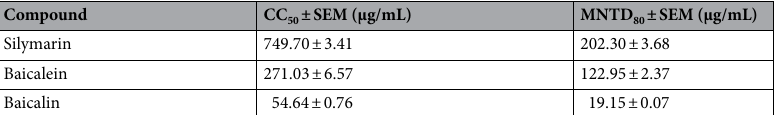
Table 1. Concentrations up to 200 µg/mL for silymarin (Fig. 1a), 100 µg/mL for baicalein (Fig. 1b), and 20 µg/ mL for baicalin (Fig. 1c) showed no significant cytotoxic effects in Vero cells after 48 h of incubation. The half-maximum cytotoxic concentration (CC 50 ) of silymarin, baicalein, and baicalin was 749.70 ± 3.41 µg/mL, 271.03 ± 6.57 µg/mL, and 54.64 ± 0.76 µg/mL, respectively. The maximum-non-toxic-dose (MNTD 80 ) of silyma- rin, baicalein and baicalin was 202.30 ± 3.68 µg/mL, 122.95 ± 2.37 µg/mL, and 19.15 ± 0.07 µg/mL respectively. Based on the MNTD